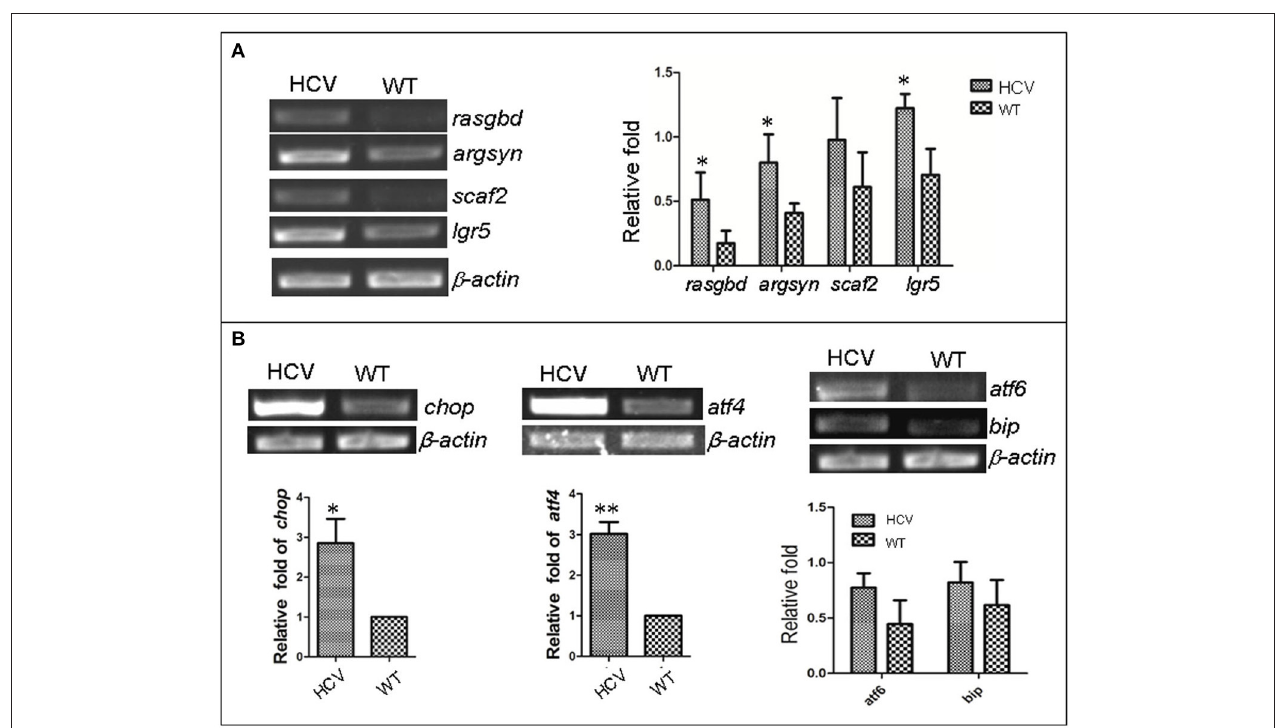
FIGURE 2 | Up-regulation of HCV- and ERS-resposive host genes through the induction of the liver-specific HCV sub-replicon. Wild type (WT) and the HCV subreplicon model (HCV) zebrafish larvae were collected at 8 dpf. Transcription levels of the designated genes were tested using RT-PCR. (A) The transcription level of HCV-responding genes ScarF2, Leugpcr, Rasgbd and Argsyn were elevated in the model larvae as compared to the WT larvae. (B) UPR marker genes chop , atf4 , atf6, and bip were also increased in the model larvae as compared to the WT larvae. β -actin was used as a sample loading control. The histograms are expressed as means ± SD from 3 independent experiments. * p < 0.05; ** p <